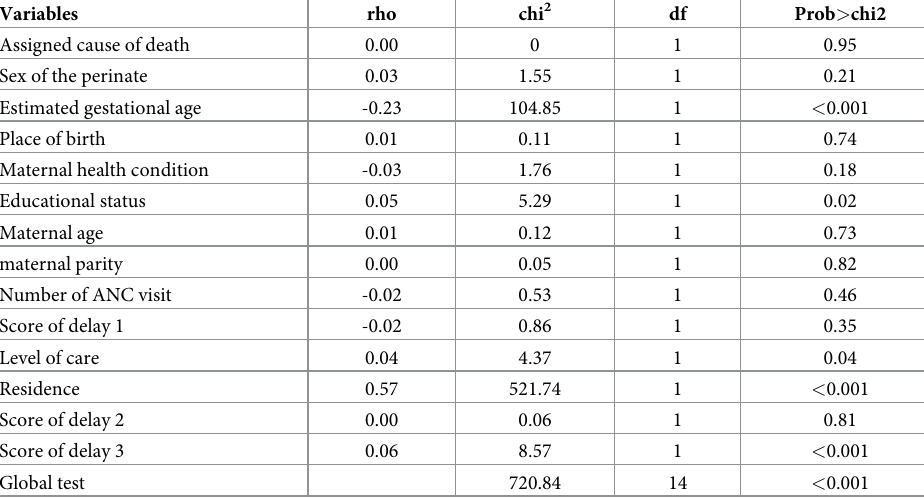
Table 2. Schoenfeld residual test for proportionality assumption of the Cox